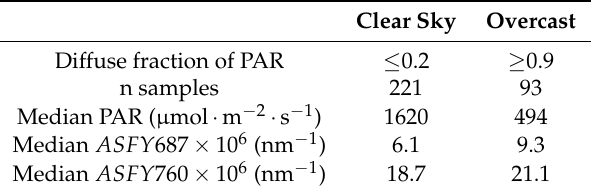
Table 3. Changes in mean ASFY upon sky conditions. Data taken from Figure 5.